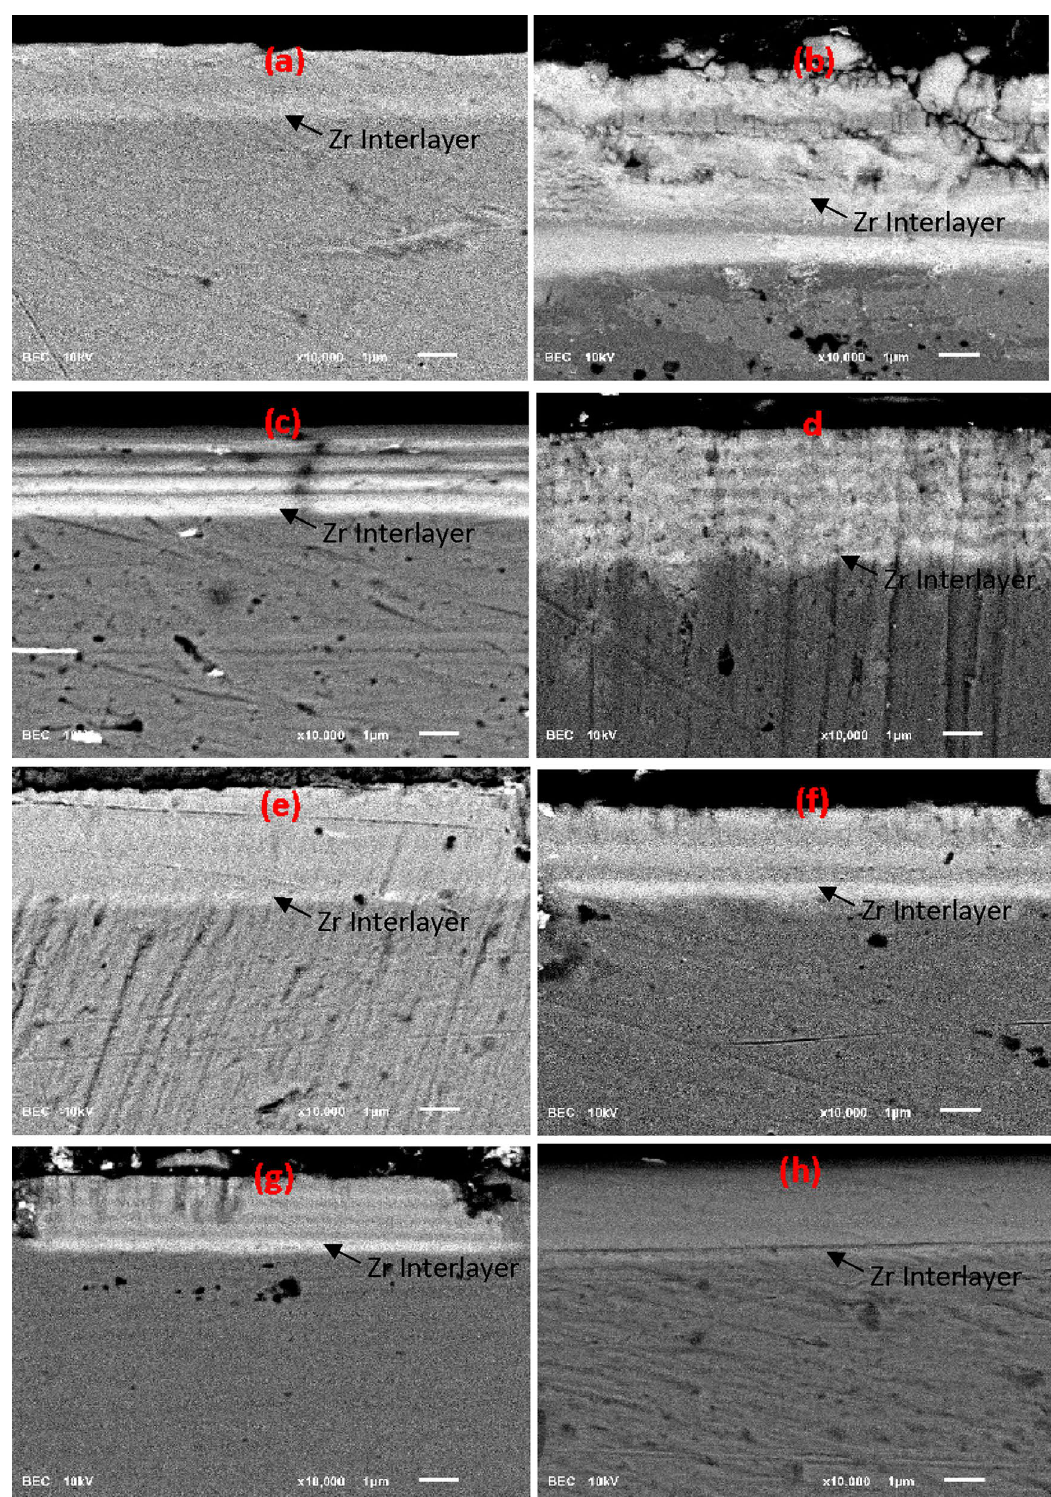
Figure 7. Backscattered electron SEM micrographs of (a) PN7, (b) PN8, (c) PN9, (d) P10, (e) PN11, (f) PN12, (g) PN13 and (h) PN14 coatings’